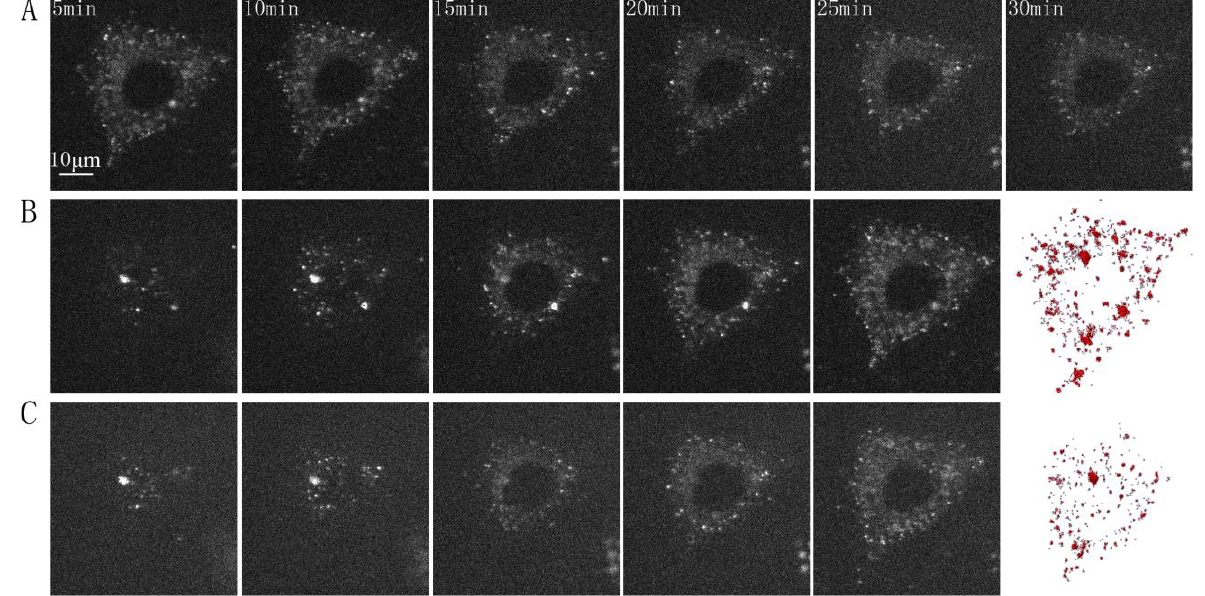
Figure 3. Internalization of GLUT4-QD complex in L6 cell. (A) Cross section of the